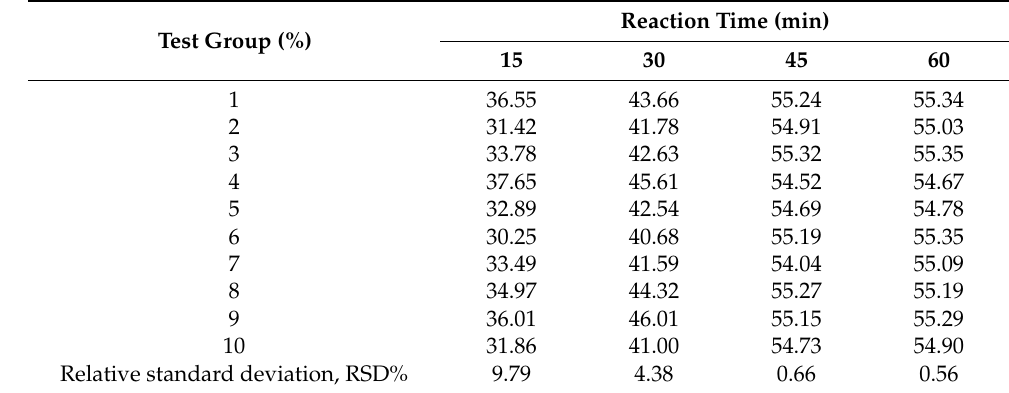
Table 2. Comparison of bioassimilated carbon content at different reaction times in potassium dichromate/ferrous sulfate redox system.